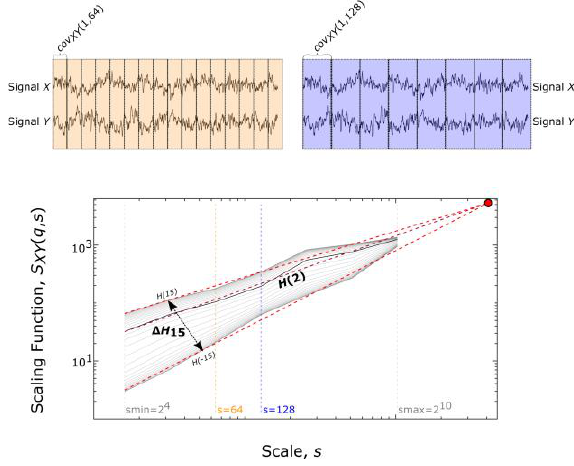
Figure 1. Endpoint parameters of multifractal time series analysis. The Focus (red dot) is used as a point of reference for simultaneously fitting linear models across data in the log-log transform of the scaling function ( S XY ( q , s )) vs. scale ( s ). The coefficient of each linear regression represents the generalized Hurst exponent H ( q ) at any given statistical moment q . H (2) describes the long-term cross-correlation between the signals X and Y , while the degree of multifractality ( ∆ H 15 ) is captured by the difference between H ( q ) at the minimal ( q = − 15) and maximal ( q = 15) statistical moments. The yellow and purple colors represent examples of scaling function estimation for s = 64 and s = 128, respectively. This is a modified version of the figure that first appeared in